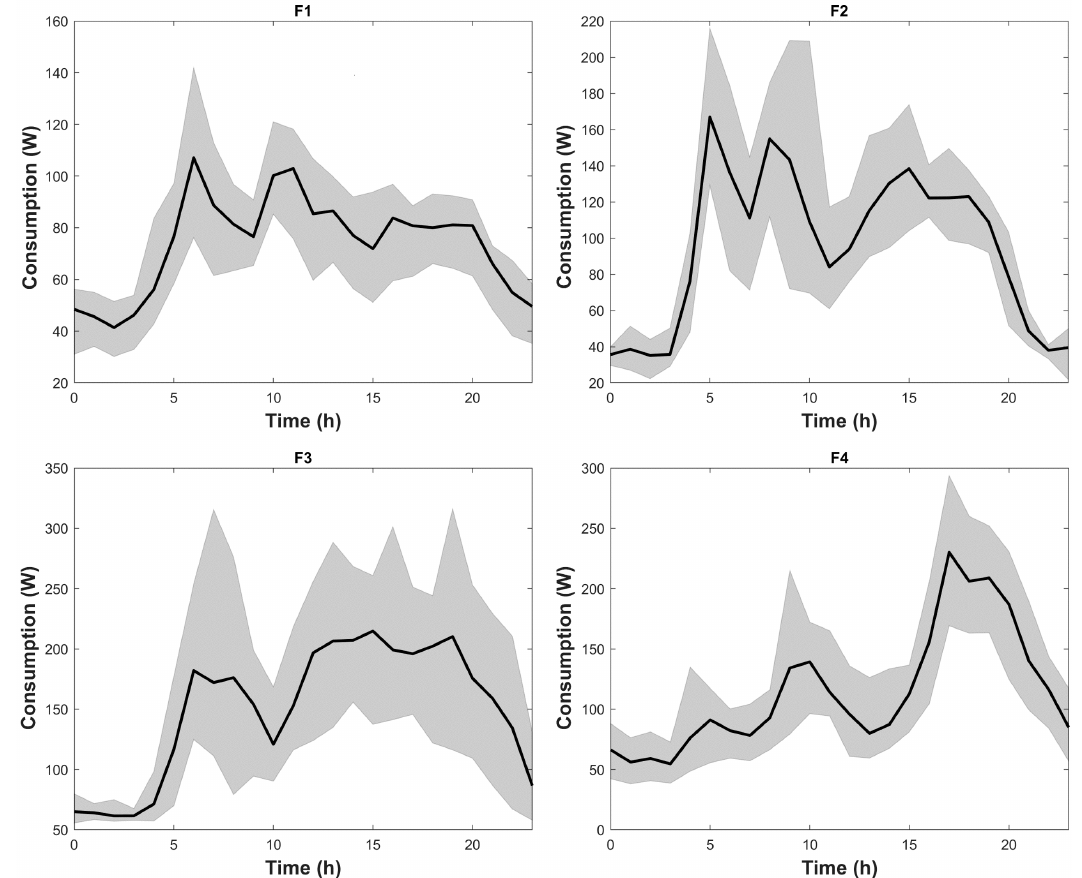
Figure 3. Hourly average annual load profiles of flats F1, F2, F3, and F4.